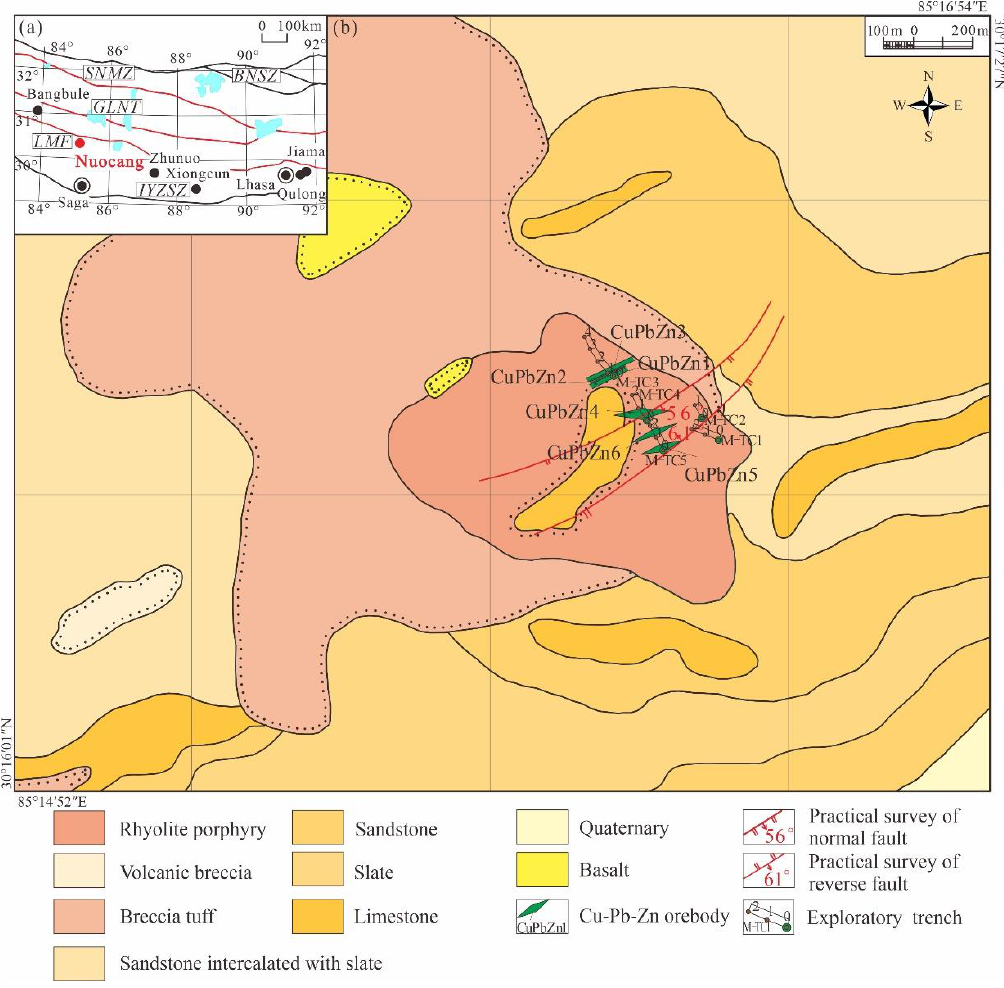
Figure 1. ( a ) Simplified geologic map of the Lhasa terrane showing the distribution of main deposits (modified after Wu et al., 2017) [2]; ( b ) geological map of Central Nuocang. Abbreviations: IYZSZ, Indus – Yarlung Zangbo suture zone; LMF, Luobadui – Milashan fault; GLNT, Geer – Longgeer – Cuoqin fault; SNMZ, Shiquan River – NamTsoMélange zone; BNSZ, Bangong – Nujiang suture zone.